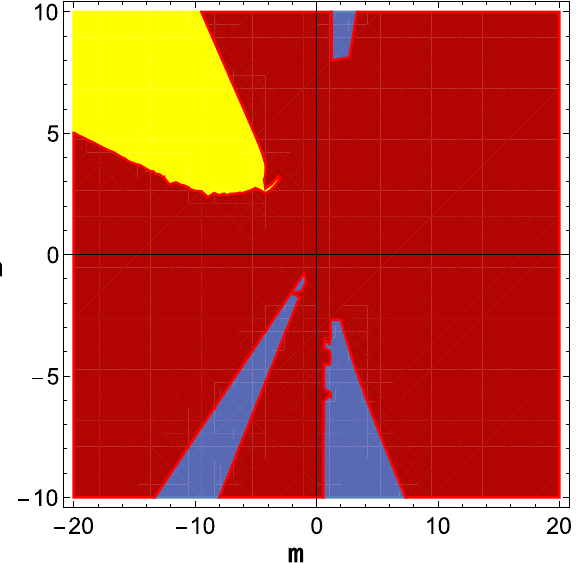
Fig. 6 The figure displays the regions in the space associated to n and m parameters for which the B critical point has the following dynamics: unstable (yellow), stable (blue), and saddle